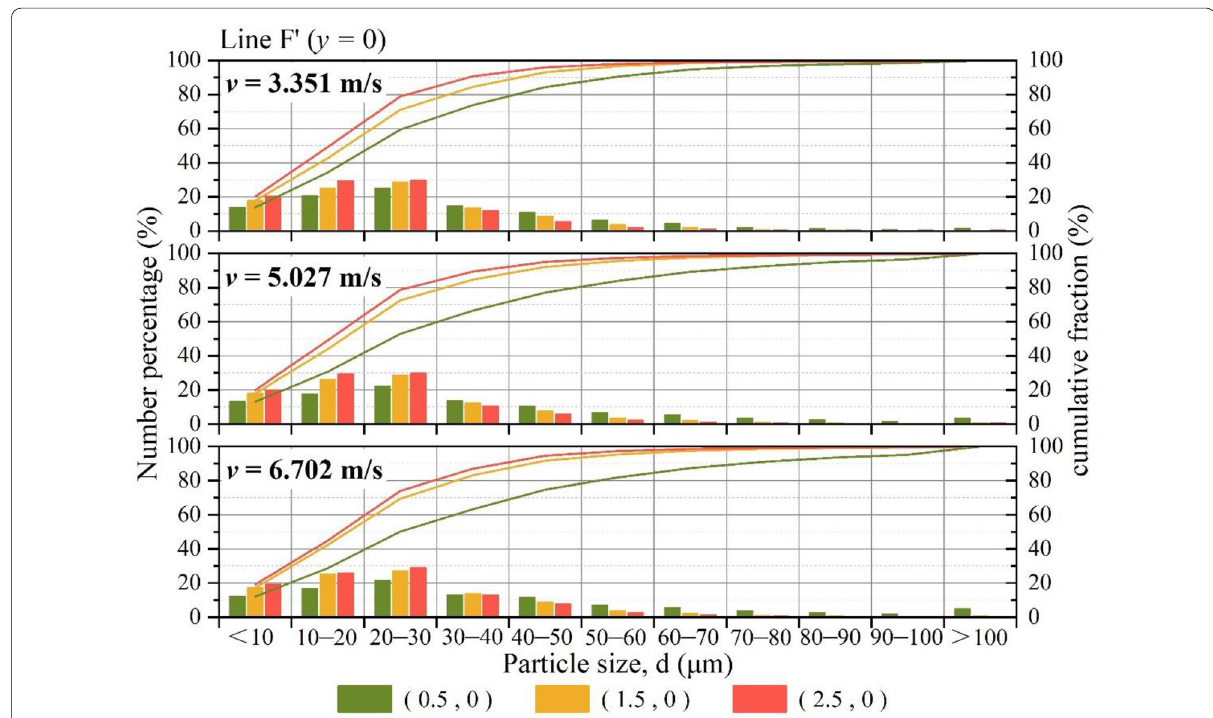
Fig. 7 The PNSD of dust particles collected from sampling points at the coordinates of (0.5, 0), (1.5, 0) and (2.5,